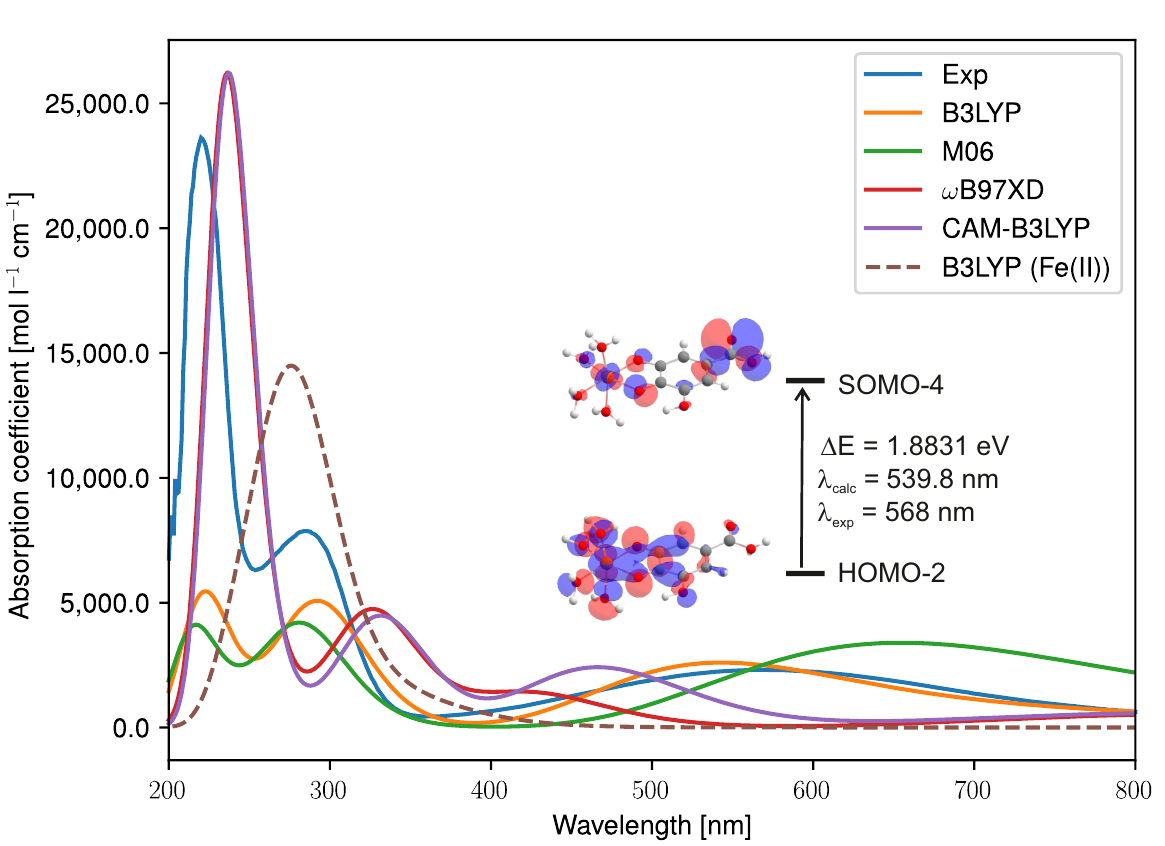
Figure 11. Comparison of the experimental (blue line) and the simulated spectra of [H 2 GAFe] + (full line) and [H 2 GAFe] (dashed line). DFT functionals were used in combination with LANL2DZ and 6-311+G(d,p) basis sets for Fe and the remaining atoms, respectively, as well as with the CPCM solvation model. The orbitals involved in the transition responsible for the broadest band at high wavelengths are depicted (HOMO, SOMO, and LUMO denote the highest-, singly, and lowest-(un)occupied molecular orbitals, respectively). In addition, the excitation energy and wavelength (experimental and calculated) of this transition are